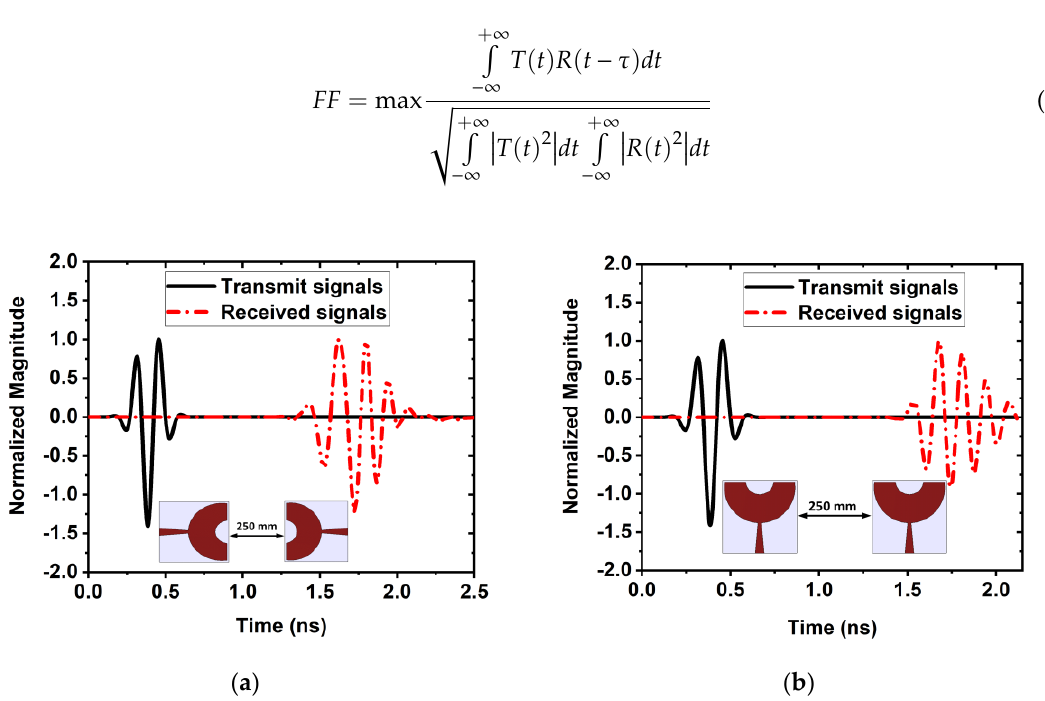
Figure 10. The normalized magnitude of the: ( a ) Face-to-face setup; ( b ) Side-by-side setup.